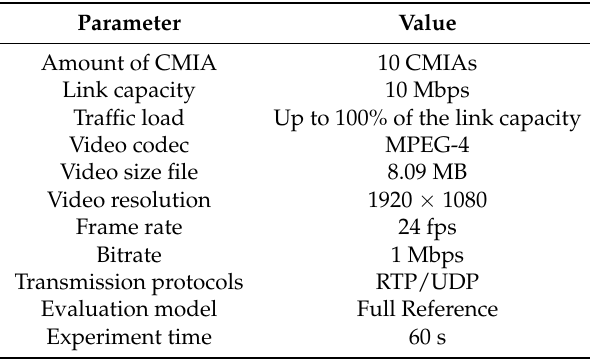
Table 3. Parameters of the